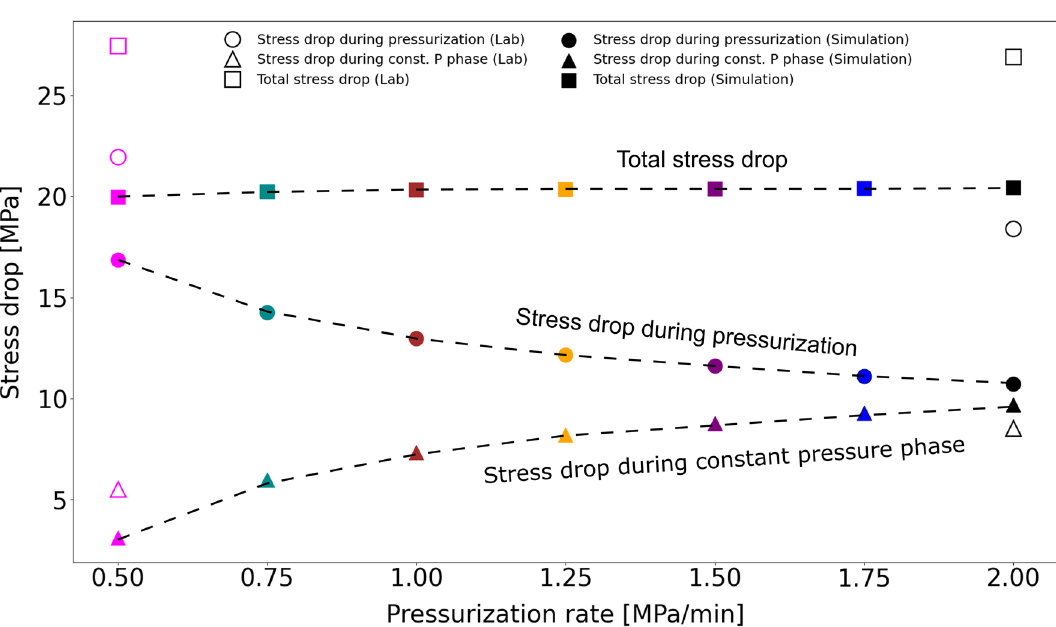
Figure 3. Parametric study on the imposed fluid pressurization rates. ( a ) Pressurization schemes; ( b ) slip velocity; ( c ) shear stress drop resolved on the fault; ( d ) cumulative slip. Dashed lines: simulated curves; solid lines: laboratory measurements. The inset in panel c shows a close-up of the simulated stress drop in two consecutive cycles. The red and blue dots mark the beginning and end of a given pressurization phase, respectively.